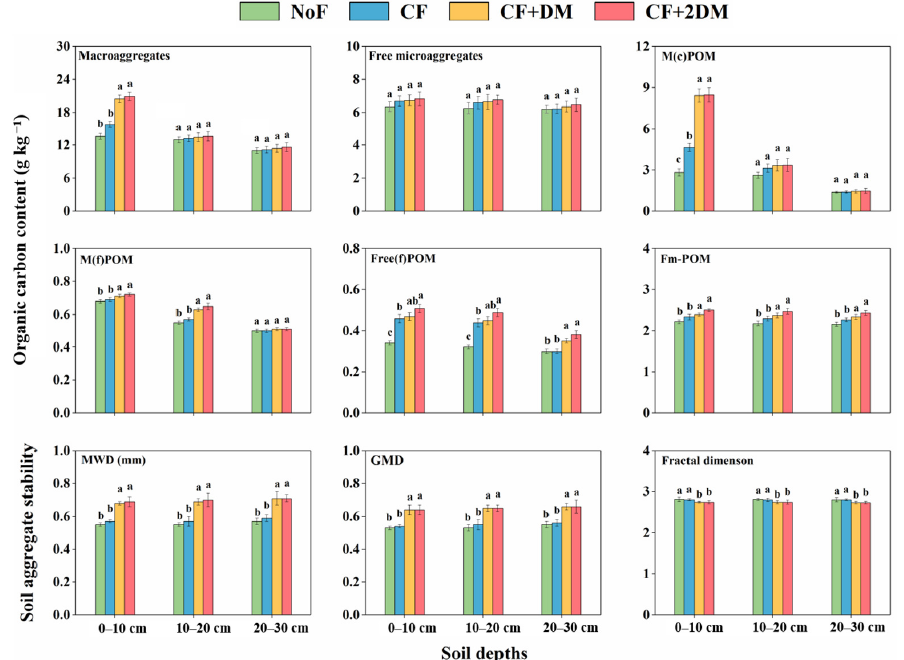
Figure 3. The contents of organic carbon fractions within hierarchical aggregates and soil aggregate stability under different fertilization managements. In the same soil layer, the various letters of the same fraction exhibited significant differences at the p < 0.05 level via Tukey’s HSD test under the four treatments. NoF, non-fertilizer. CF, only chemical fertilizer. CF + DM, chemical fertilizer plus with single dairy manure. CF + 2DM, chemical fertilizer plus with double dairy manure. The specific meanings of organic matter fractions with abbreviations are presented in Table